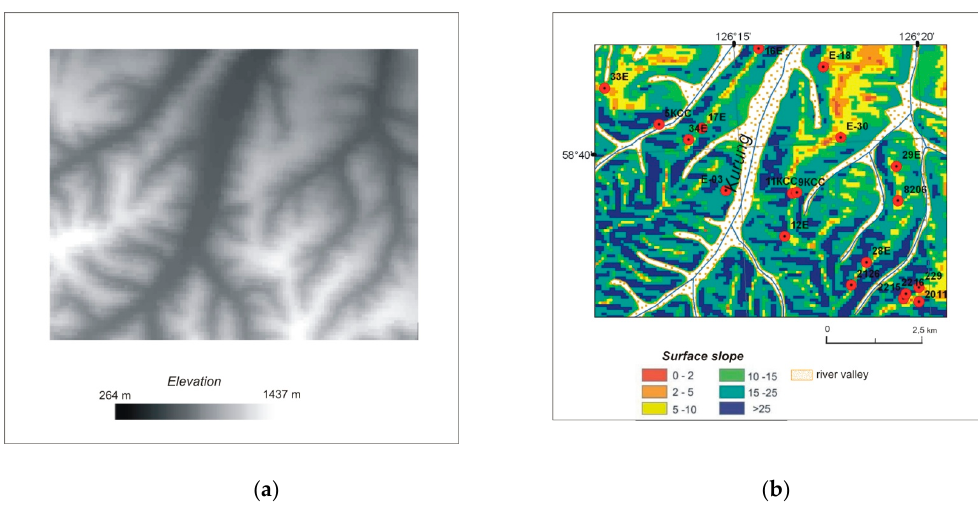
Figure 2. SRTM data processing for relief analysis (on the example Elkon Massif). ( a ) Digital model SRTM; ( b ) The surface slope map. Numbered dots—numbers of geothermal boreholes.